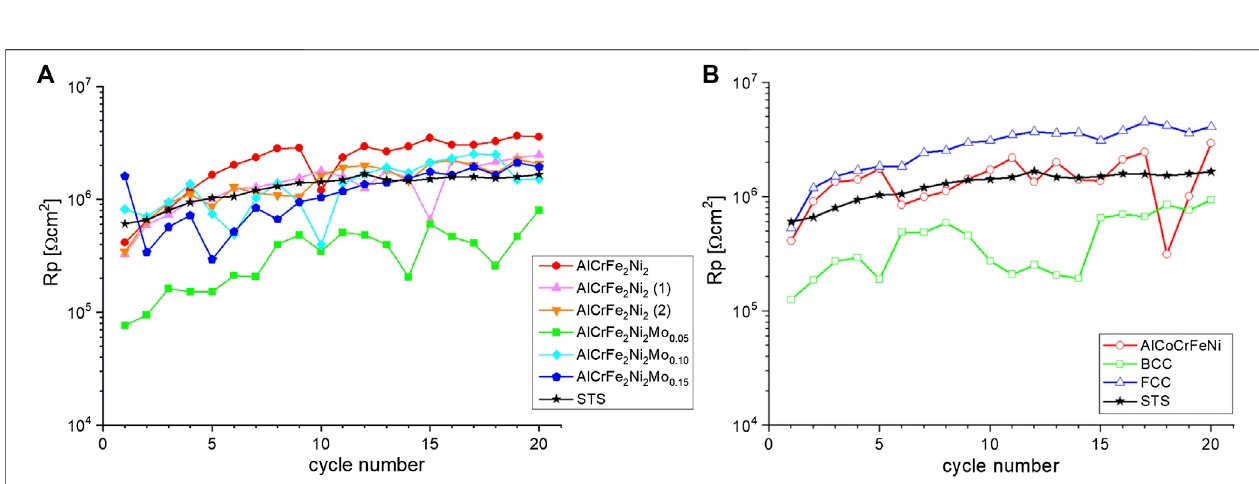
FIGURE 6 | Variations of polarization resistance over 20 consecutive cycles in 3.5 wt.% NaCl for Co-free alloys and STS (A) , and for three quinary alloys and STS (B) .